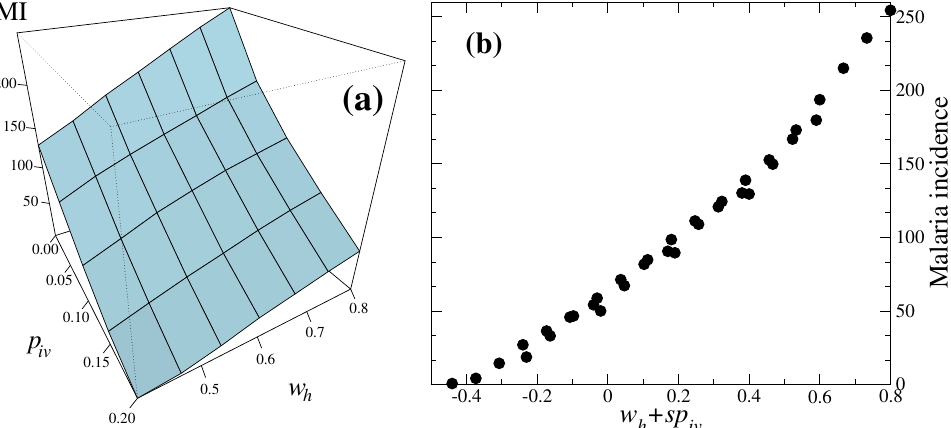
Figure 4. ( a ) Malaria incidence as a function of the human-to-mosquito transmission efficiency w h and the ivermectin probability p iv , showing that isolines of malaria spreading are approximately a linear combination of both variables. Therefore, we plot in ( b ) the malaria incidence as a function of the linear combination w h + sP iv with s = − 4.2, clearly showing a gradual transition from elimination to endemic prevalence. In all cases, the PW-rule of 20/80 was used, corresponding to θ =